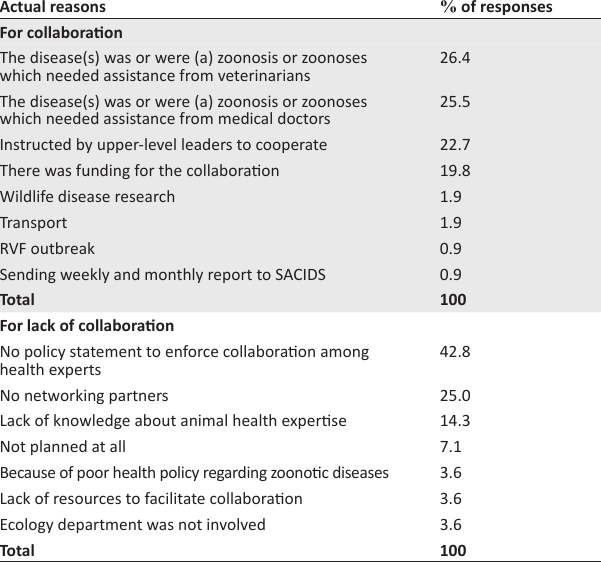
TABLE 4: Actual bridges and